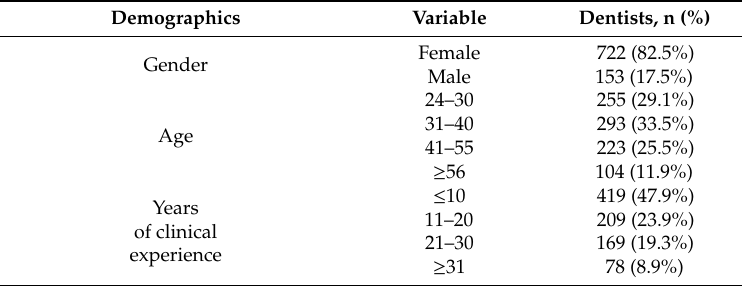
Table 1. Demographic characteristics of the group of surveyed Polish dentists (n =